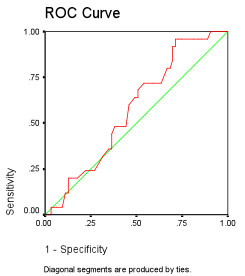
ROC Area Under the Curve = 0.58.